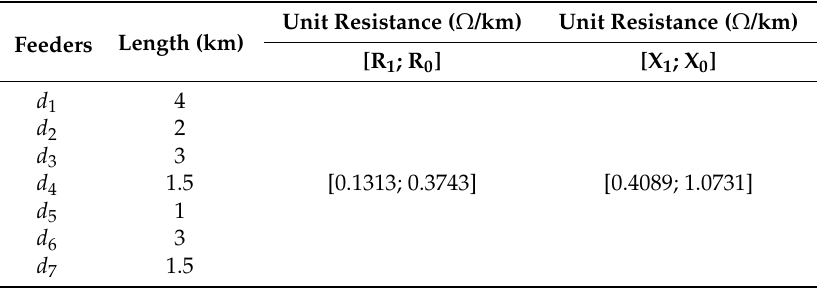
Table 3. Parameters of the feeders